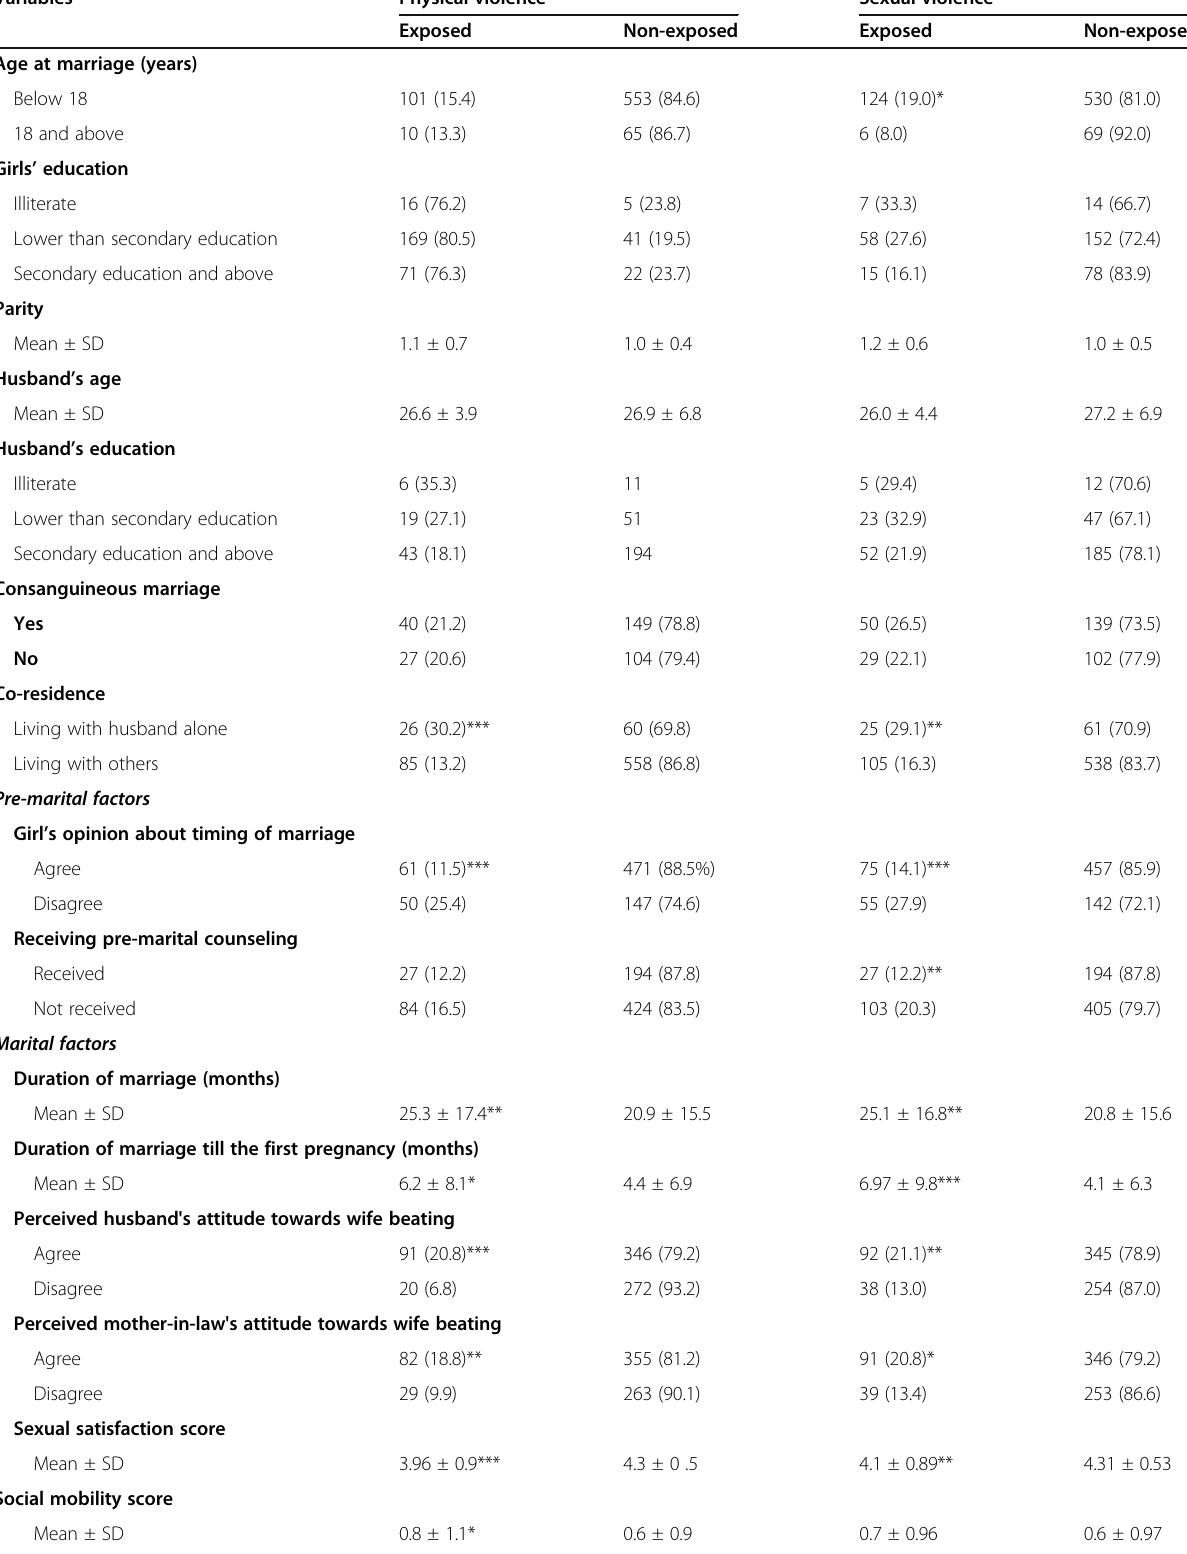
Table 3 Factors affecting exposure of married adolescent girls (MAGs) to physical and sexual violence, Upper Egypt